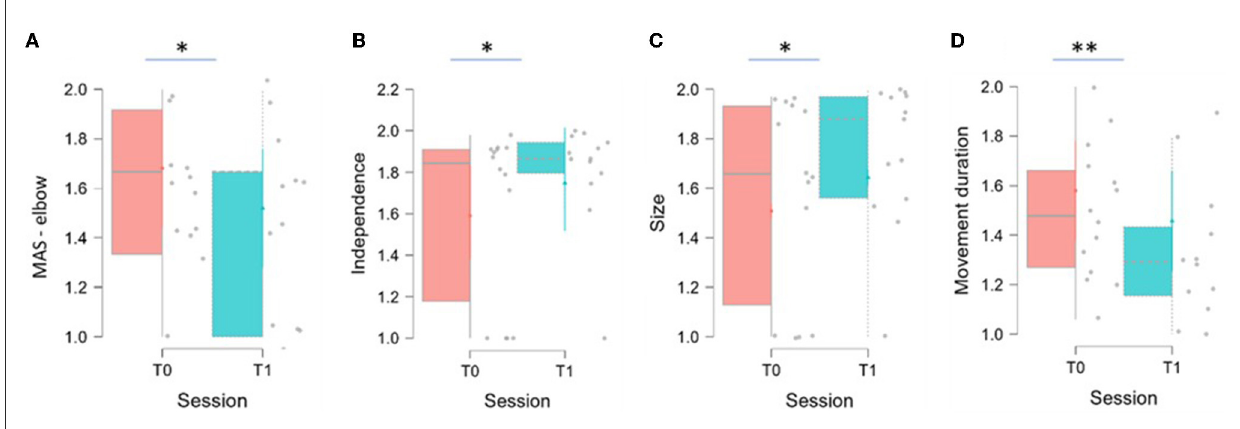
FIGURE6 Graphs related to significant data.